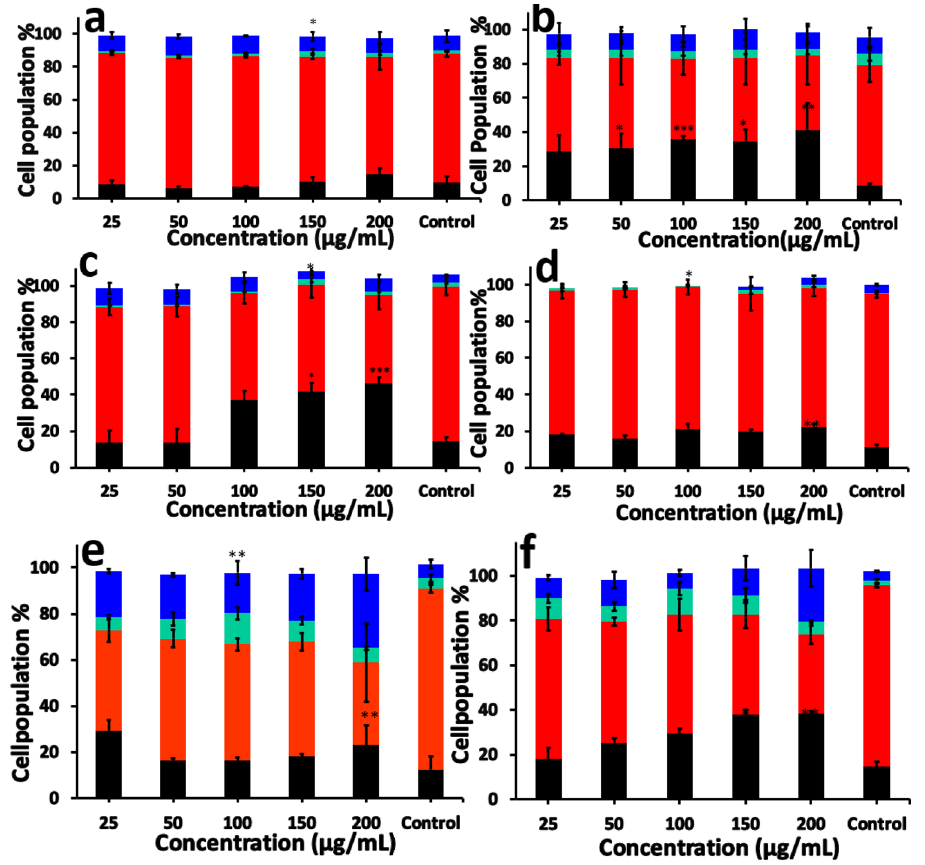
Figure 11. Cell cycle analysis after incubation with PVC NPs for ( a ) 24 h, ( b ) 48 h, ( c ) 72 h and PMMA NPs for ( d ) 24 h, ( e ) 48 h, ( f ) 72 h. SubG1 ( ■ ), G0/G1 ( ), S ( ), G2/M ( ). The results are given as % cell cycle distribution with respect to concentration. The values represent the mean ± SEM of three experiments. Statistical analysis was done by one-way ANOVA (* p < 0.05, ** p < 0.01, *** p < 0.001, **** p < 0.0001) compared to the